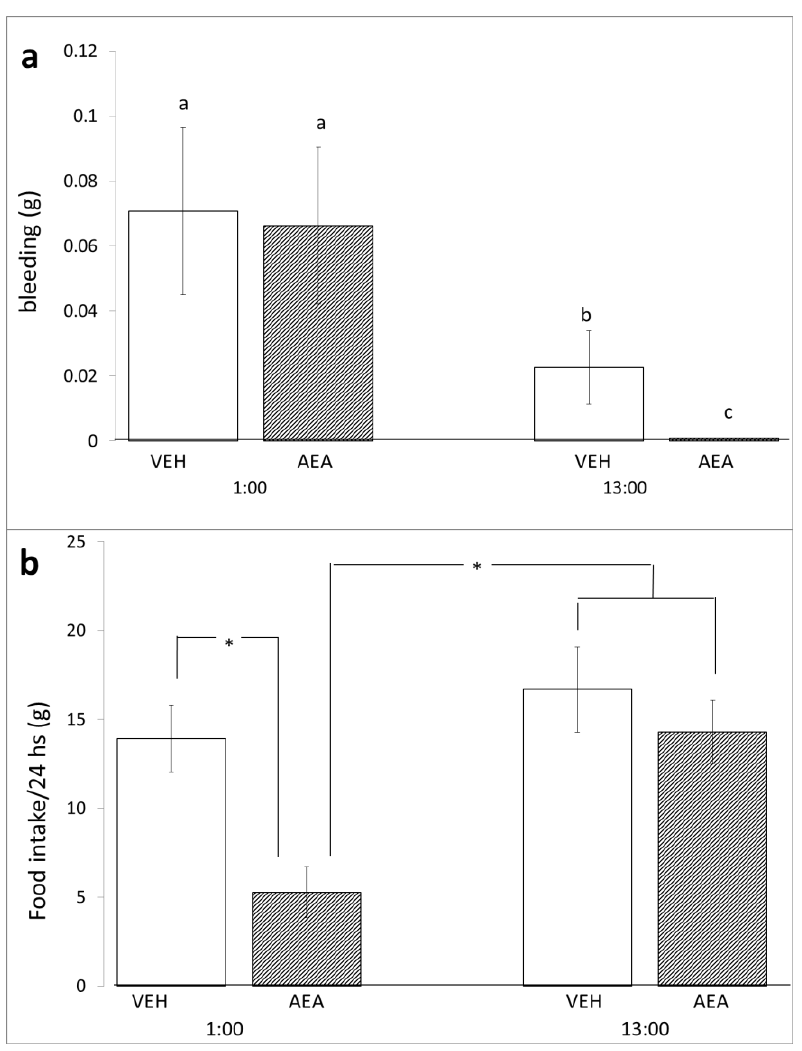
Figure 1. Effects of Traumatic Brain Injury (TBI) on bleeding, food intake, body weight differences, and neurobiological scores. The bars represent the means ± standard error of the mean (SEM) of ( a ) bleeding immediately after the TBI; ( b ) food intake; ( c ) body weight loss; and ( d ) neurobiological scores one day after TBI; ( a ) The bars with the same letter